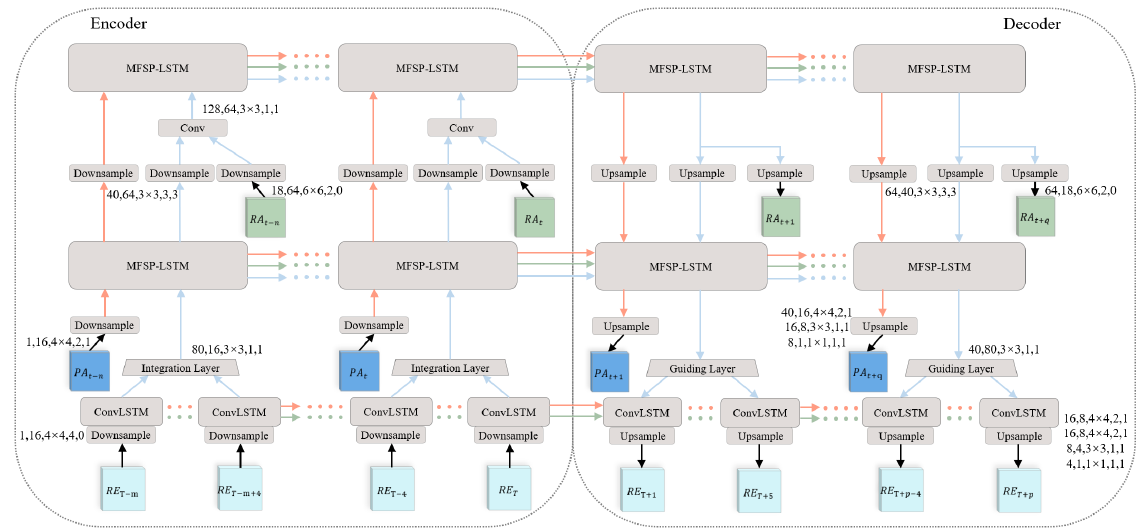
Figure 4. The three-input three-output MFSP-Net architecture. The three types of data are radar echo data RE , precipitation amount grid data PA , and reanalysis data RA . MFSP-Net forecasts the PA t + 1 · · · PA t + q , RA t + 1 · · · RA t + q and RE T + 1 · · · RE T + p in the future given the previous PA t − n · · · PA t , RA t − n · · · RA t and RE T − m · · · RE T including the current